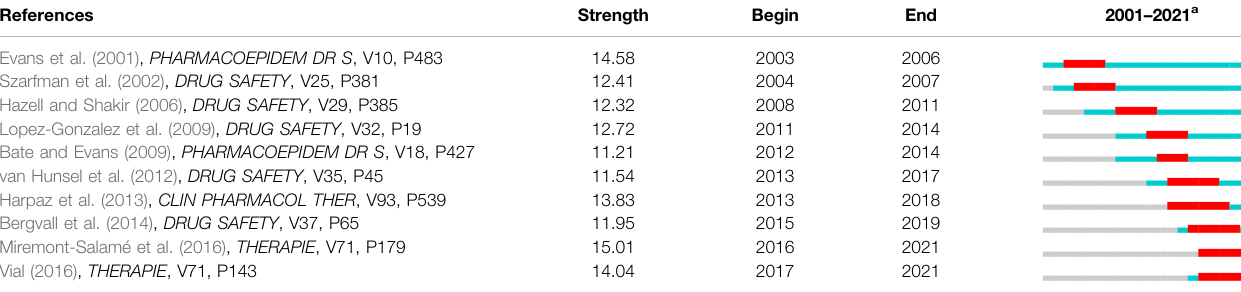
TABLE 3 | Top 10 references with the strongest citation bursts on pharmacovigilance from 1974 to